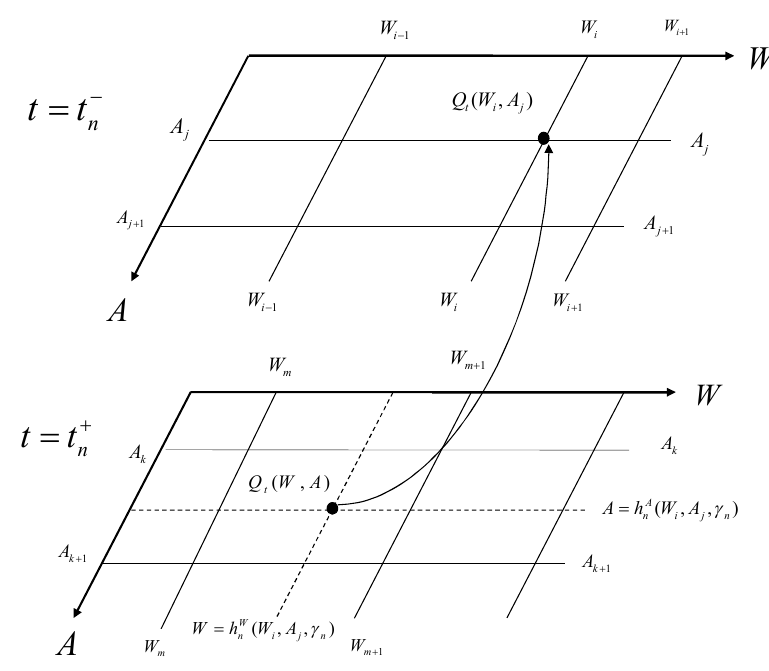
Figure 1. Illustration of the application of jump condition. The value Q t ( W i , A j ) at t = t − n and at the node point ( W i , A j ) equals to Q t ( W , A ) at t = t + n with W = h W n ( W i , A j , γ n ) and A = h A n ( W i , A j , γ n ) . The point ( W , A ) is located inside the grid bounded by ( W m , W m + 1 ) and ( A k , A k + 1 )